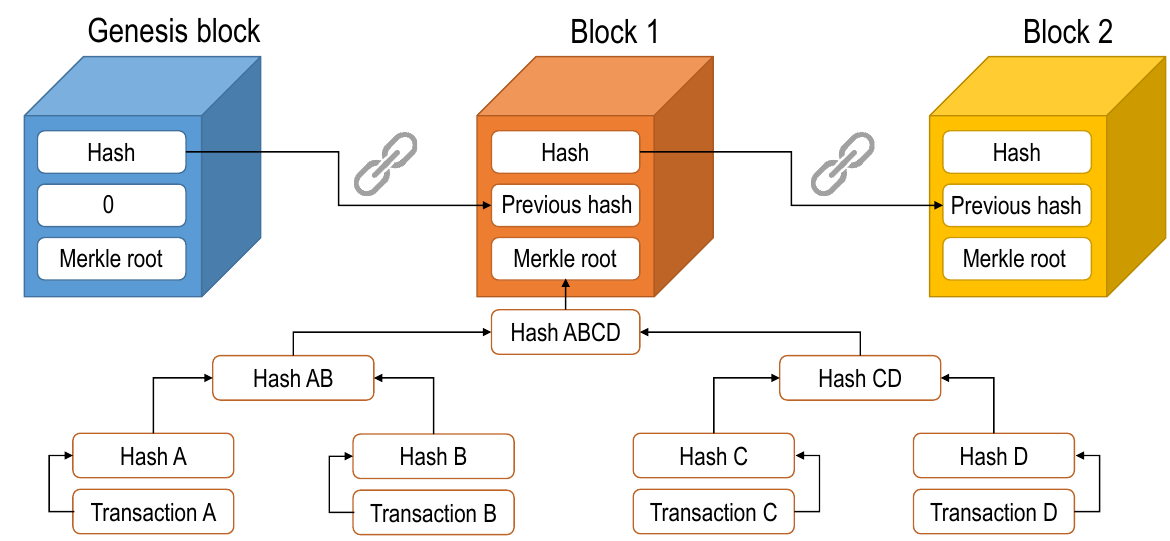
Figure 1. Blockchain